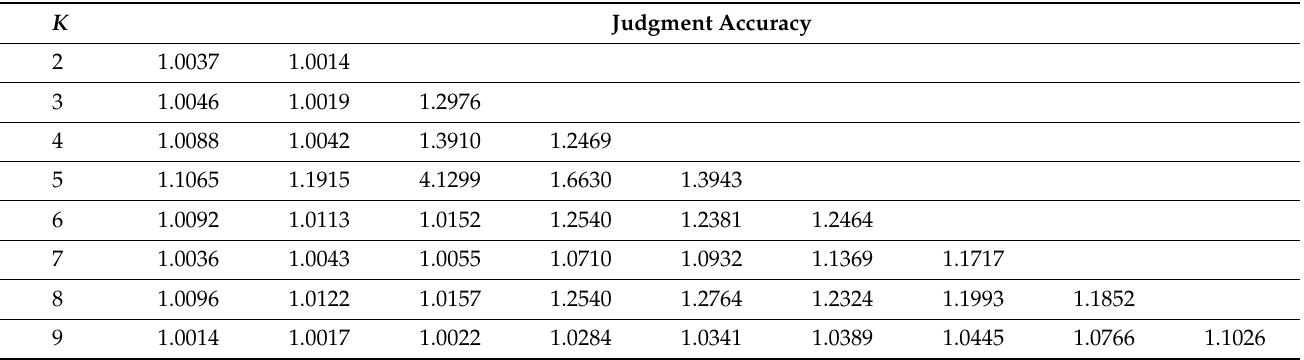
Table 5. The judgment accuracy of each order under different K